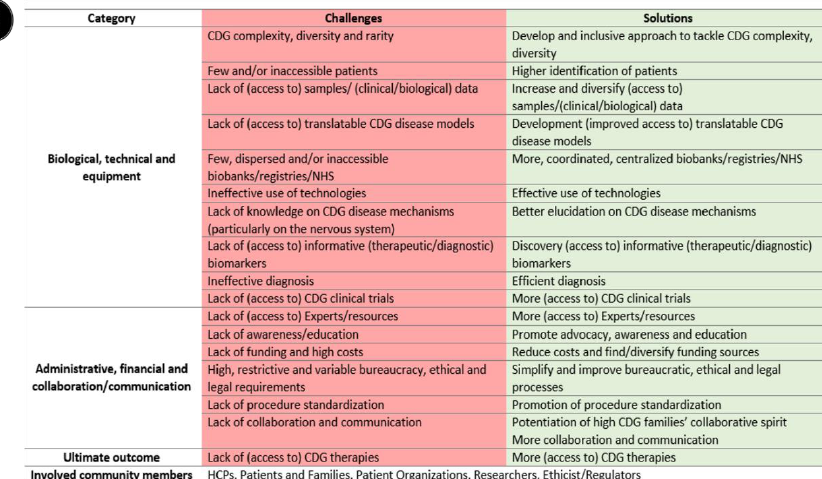
Figure 3. Overview of biomedical therapy-driven research challenges and solutions identified by the CDG community. ( A ) Challenges, ( B ) Solutions, and ( C ) Resume table of panels A and B. On panels A and B, the coloured inside circle shows the biological/technical/equipment challenges or solutions, while the outer circle includes the administrative/regulatory, funds/costs, and communi- cation/collaboration challenges or solutions. The main CDG community members involved in and impacted by these challenges and solutions are depicted in the outer circle. Legend: → — one direc- tion flow; ↔ — bidirectional flow; | → — flow interruption or blockage; X — blockage, low levels or quantity, and/or inaccessibility; √ — availability, increased levels or quantity and accessibility.